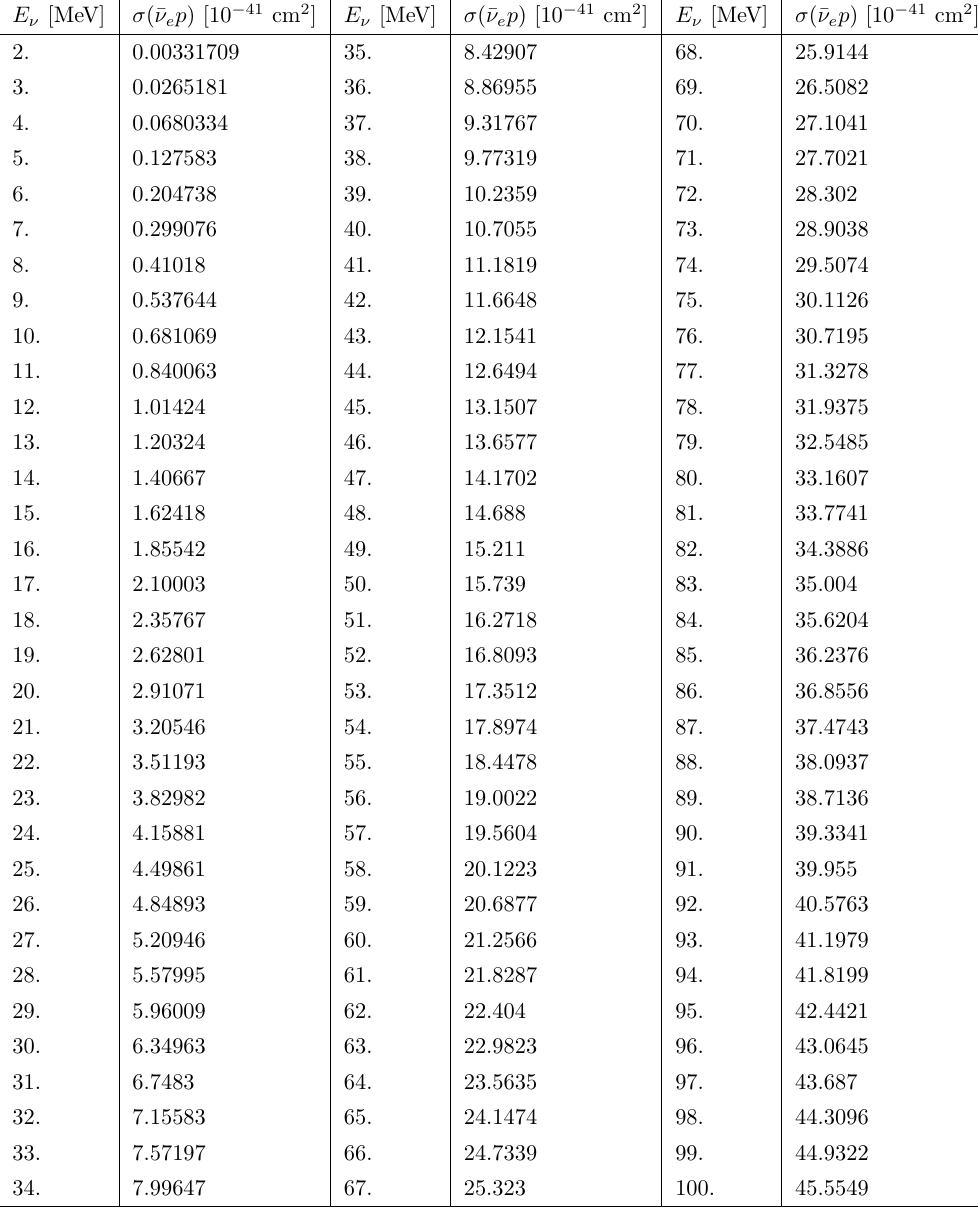
Table 3 . Numerical values (in the hyper-conservative case) for the IBD ¯ ν e p → e + n cross section as function of the neutrino